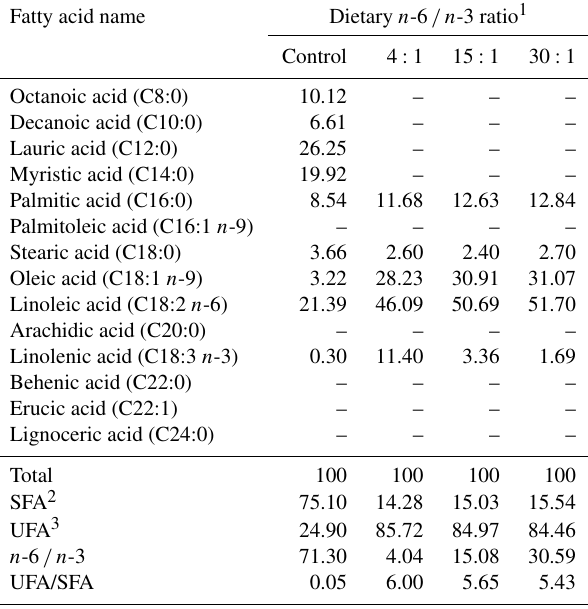
Table 2. Fatty acid composition of the experimental diets (grams per 100g total fatty